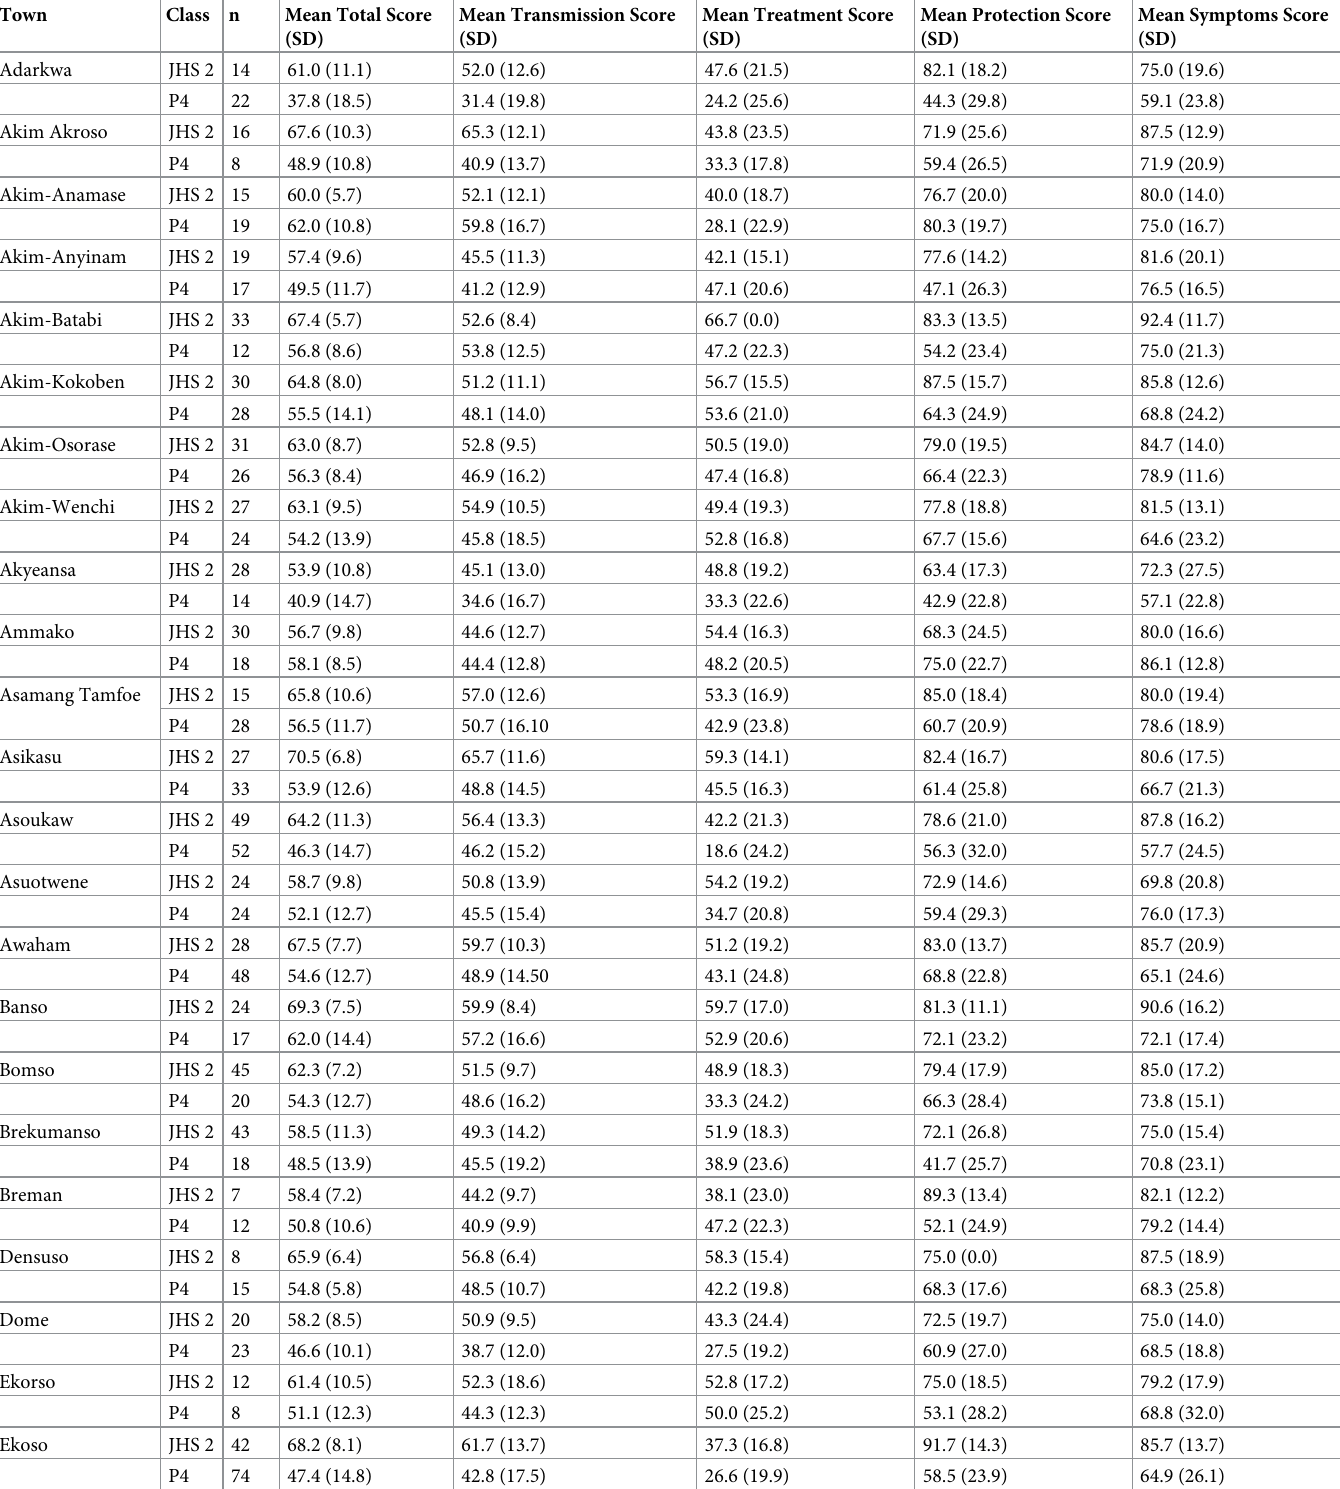
Table 1. Scores on a 22-question UGS knowledge survey for schoolchildren in the Eastern Region,